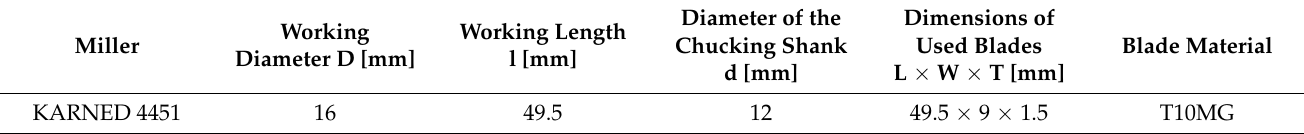
Table 2. Technical and technological parameters of the milling cutter.